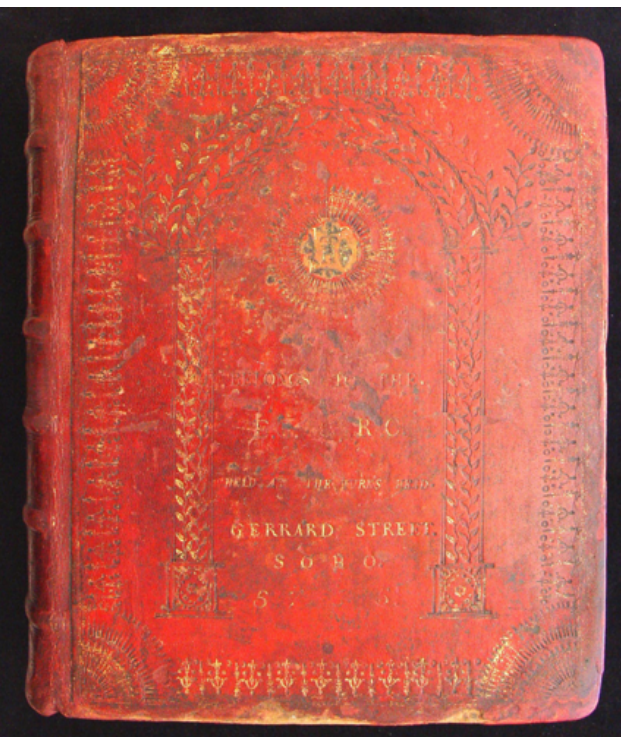
Fig. 6. ‘Brother Hutchinson (probably binder John Hutchison of Piccadilly referred to in later documents) was paid 18 shillings for binding this Bible’. Copyright and reproduced by permission of the Museum of Freemasonry, London. L64511.